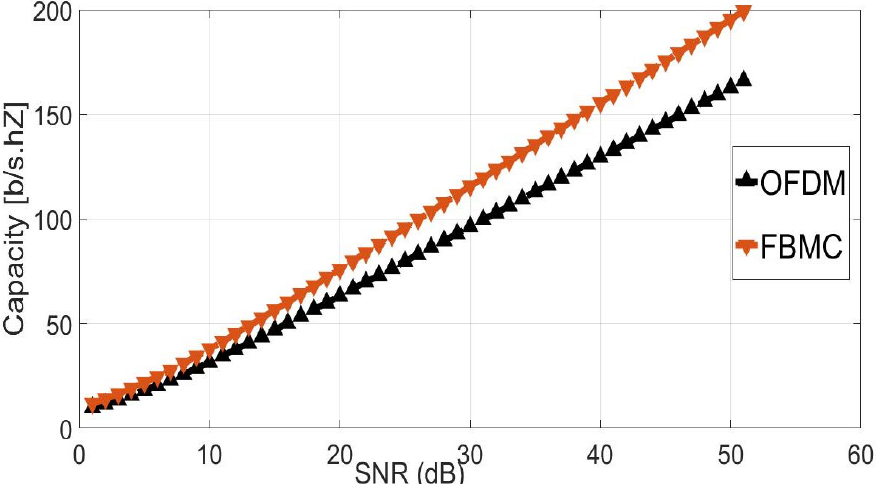
Figure 7. Capacity. Figure 7.